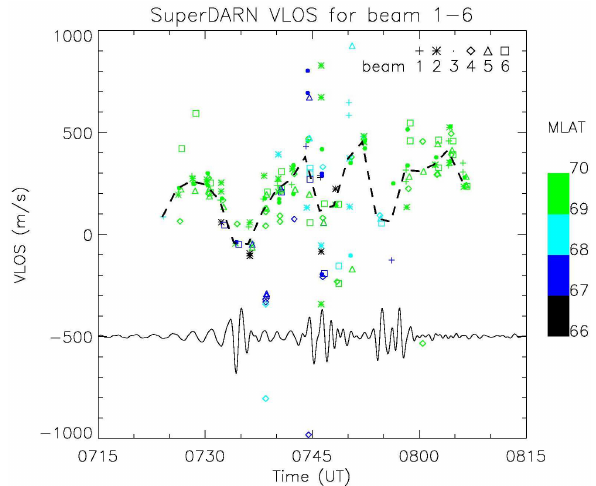
Figure 15 A plot of the Saskatoon radar VLOS on beams 1 to 6 and the Pi2 activity. The dashed line joins the median value (over the 6 beams) of the velocities observed during each 2-minute scan, in the magnetic latitude range 66-70 (cid:176) . Positive velocities denote westward electric field, while negative velocities denote eastward field.